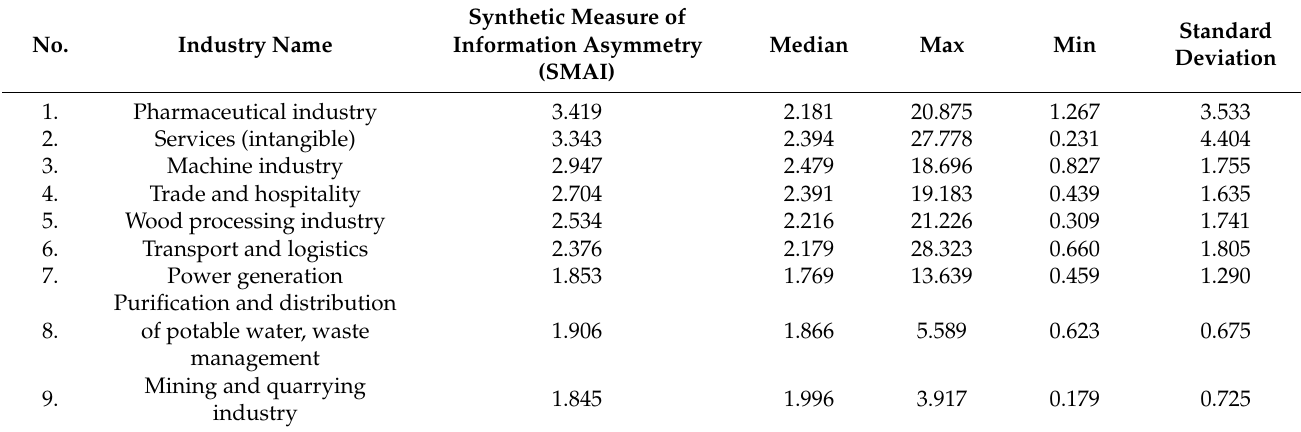
Table 1. Synthetic measure of information asymmetry (SMAI) by industry (%),